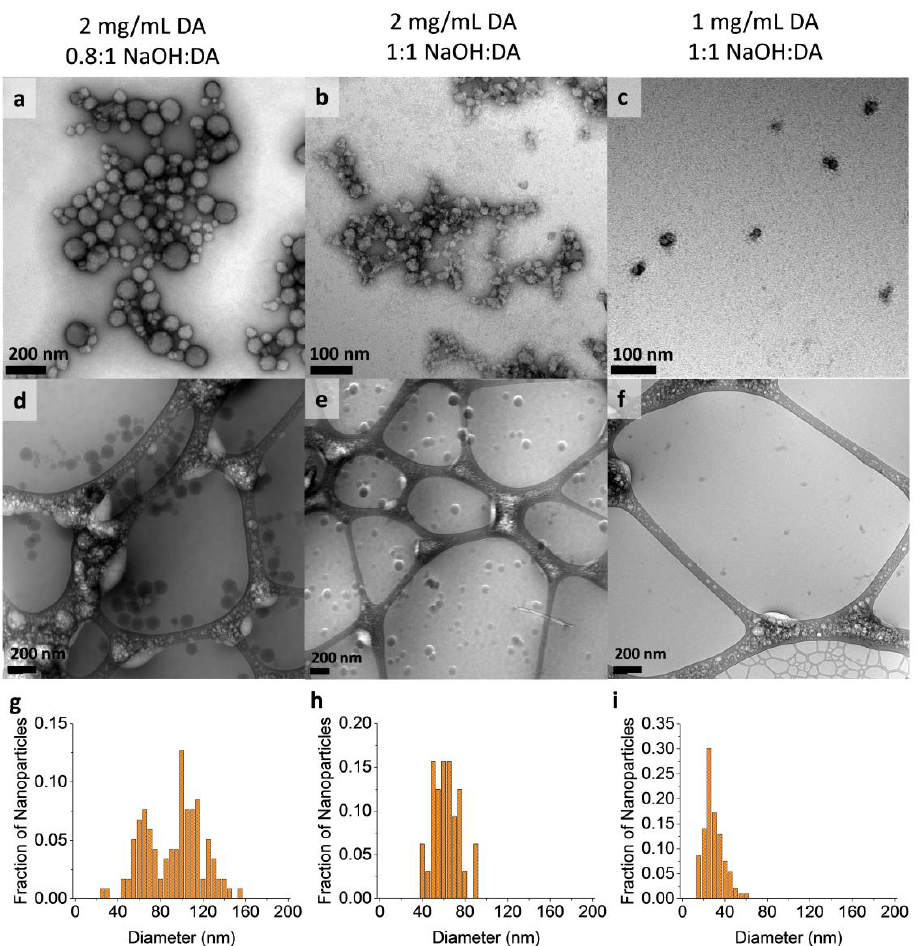
Figure 3. Transmission electron microscopy (TEM) images of MMNPs and quantitative analysis of nanoparticle diameter grown at the conditions specified at the top of each column. ( a – c ) TEM images with uranyl acetate negative stain. ( d – f ) Cryo-TEM images were taken without staining. Nanoparticles are spherical but have rougher appearances as diameter decreases. ( g – i ) Distribution of MMNP diameters in cryo-TEM images.